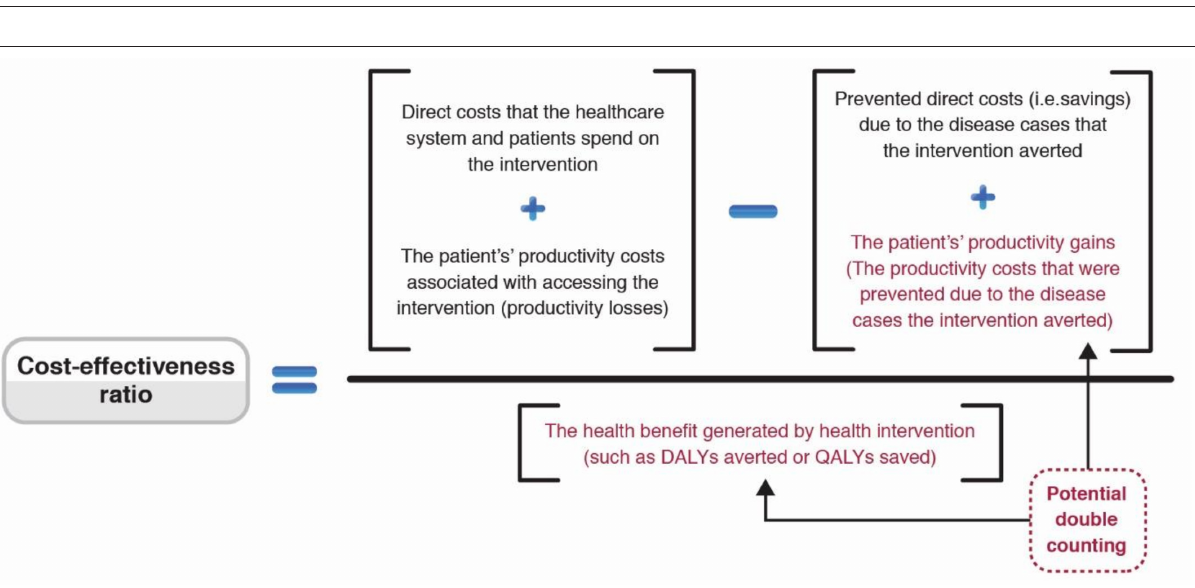
FIGURE 4 | Schematic surrounding the inclusion of productivity costs within cost-effectiveness ratios. Adapted from